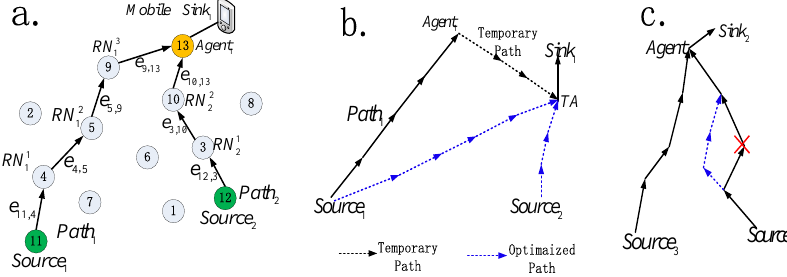
Figure 2. ( a ) Illustration for routing tree; ( b ) Routing recover for mobile moves away; ( c ) Routing recover for relay node failed.